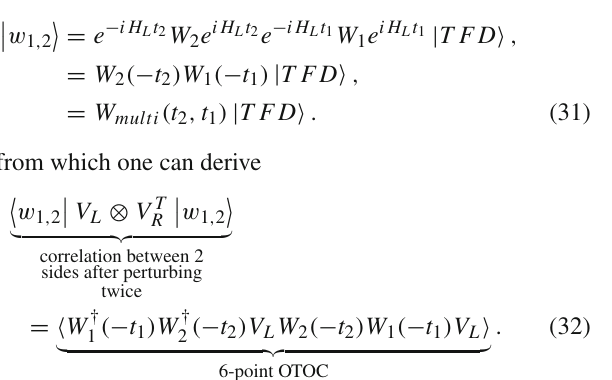
process introduced above twice, that is,